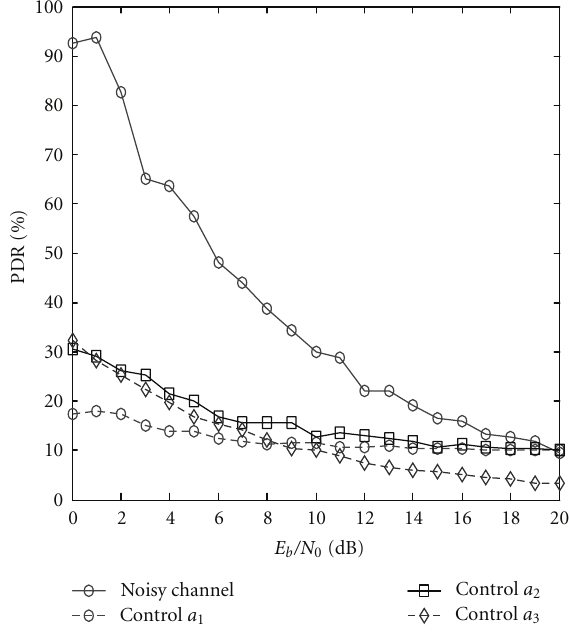
Figure 14: PDR of the reconstructed signal through a fading